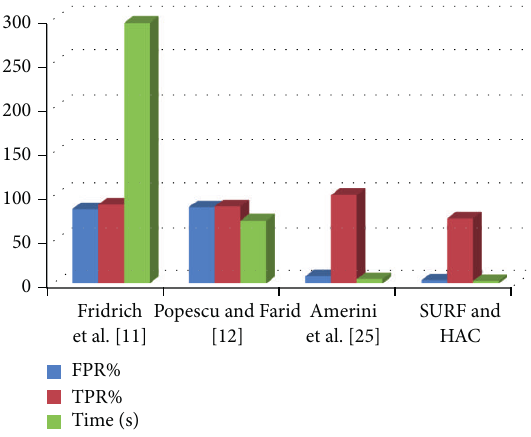
Figure 9: Performance of the methods represented in graph.